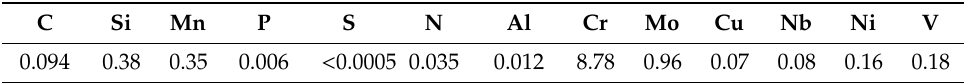
Table 1. Chemical composition of the as-received P91 steel plate